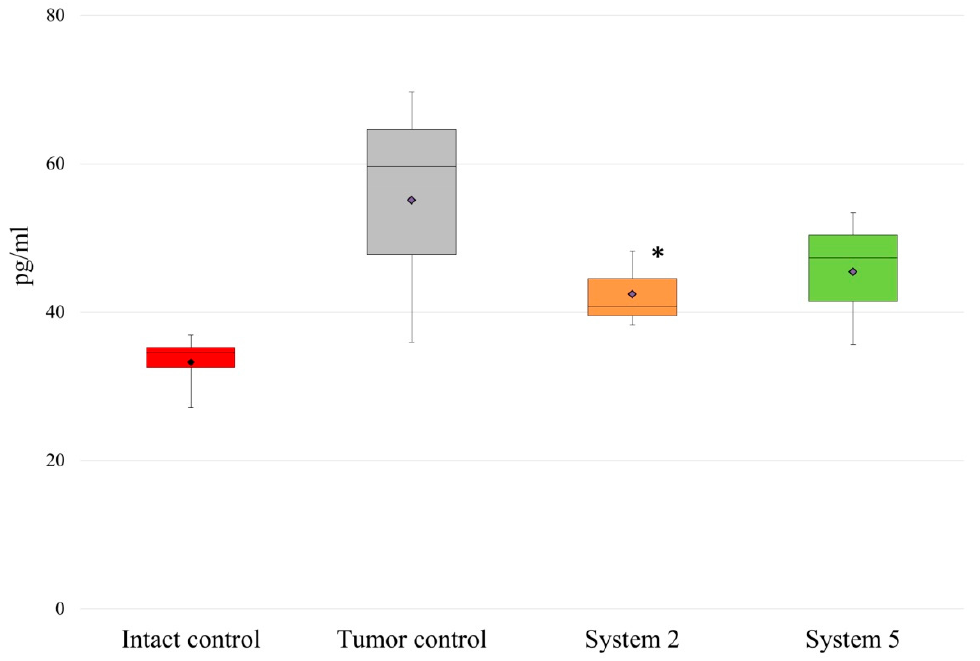
Figure 2. Changes in IL-10 concentration in response to administration of the polymeric systems. Rats were administered i.p. with 9 mg/kg polymeric system (System 2 or System 5) once on the 10th day, which corresponded to the beginning of oncogenesis and formation of tumor nodes, and the activation of the immune system. Control rats received PBS. Results are representative of four independent assays and show the Median (Me) with interquartile range (25th percentile; 75th percentile) of triplicate determinations for one of four experiments. Differences from (*) intact rats or (**) control tu- mor-bearing rats were significant at p <